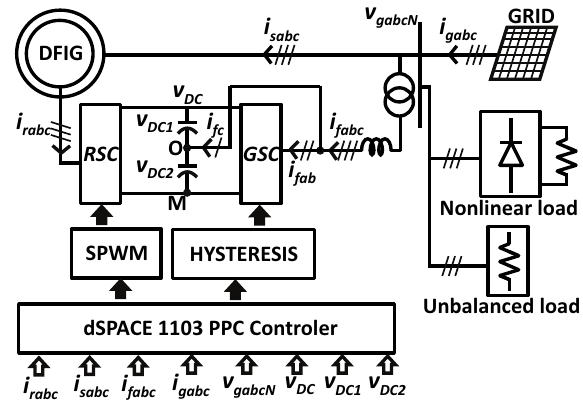
Figure 1. Type III WTG System with 2L2B Topology as GSC.